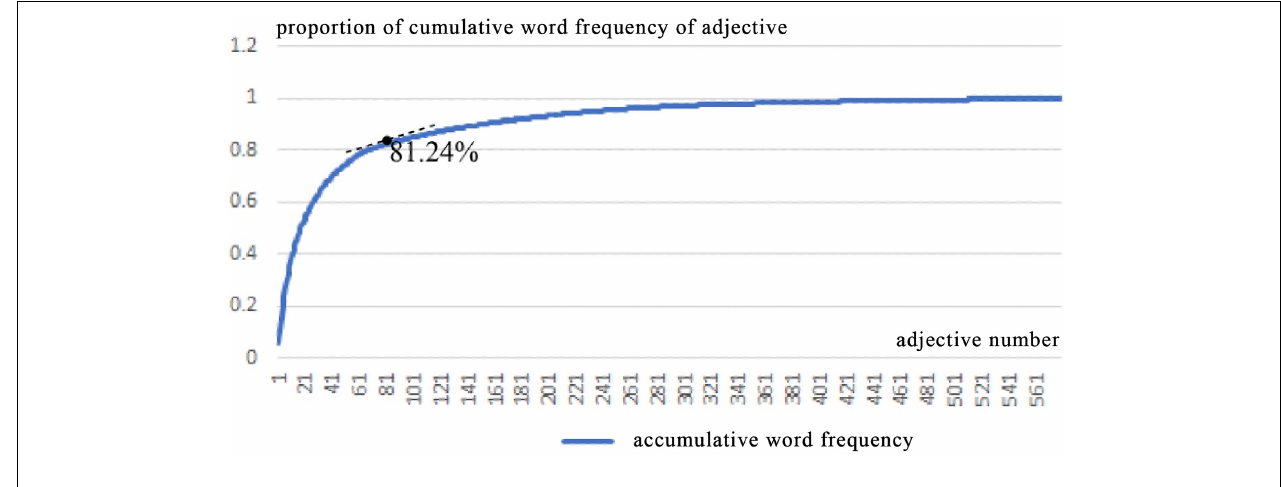
FIGURE 6 | Relationship between adjective number and proportion of cumulative word frequency. TABLE 1 | Thematized example of nouns